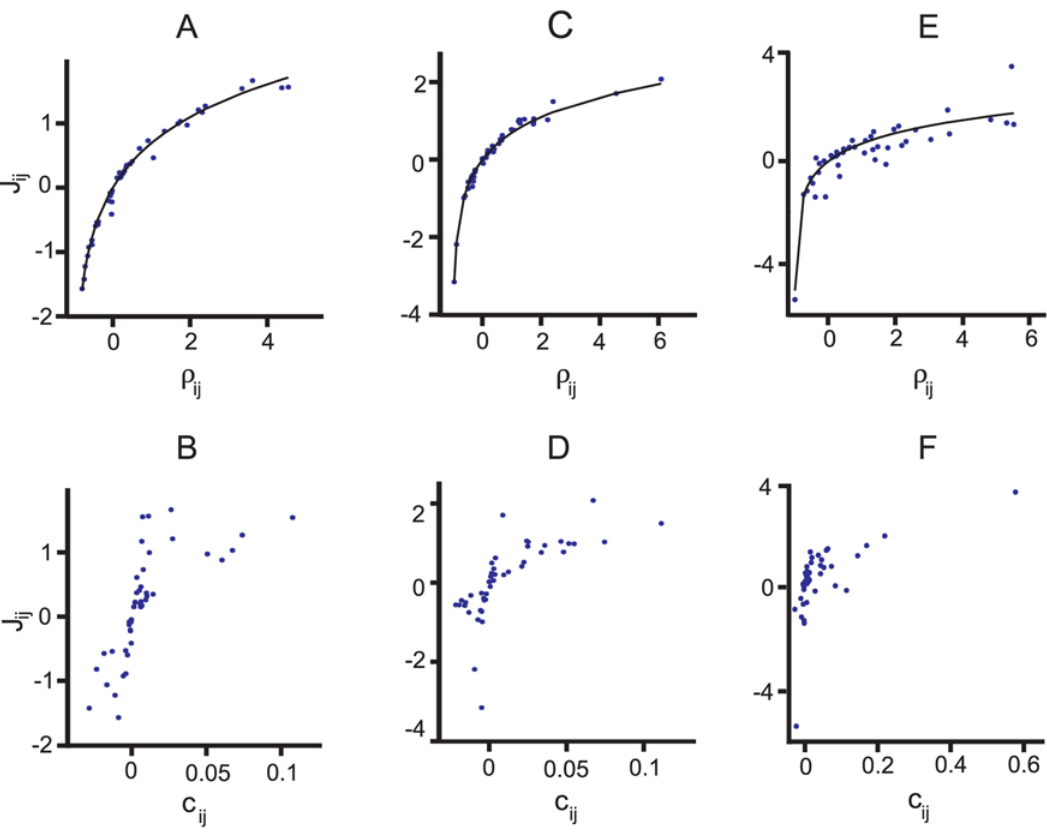
Figure 7. The relation between pairwise couplings and pairwise correlations. This figure shows that there is a simple relation between J ij and r ij , but not between J ij and c ij . (A, C, E) J ij versus the normalized coefficients, r ij (blue points), along with the predicted relationship, via Eq. (18b) (black line). (B, D, F) J ij versus the Pearson correlation coefficients, c ij , Eq. (26) (blue points). The three columns correspond exactly to the columns in Fig. 5 from left to right; that is, nd t ~ 0 : 024 for (A, B), nd t ~ 0 : 029 for (C, D), and nd t ~ 0 : 037 for (E, F). The prediction in the top row (black line) matches the data well, even in the rightmost column.